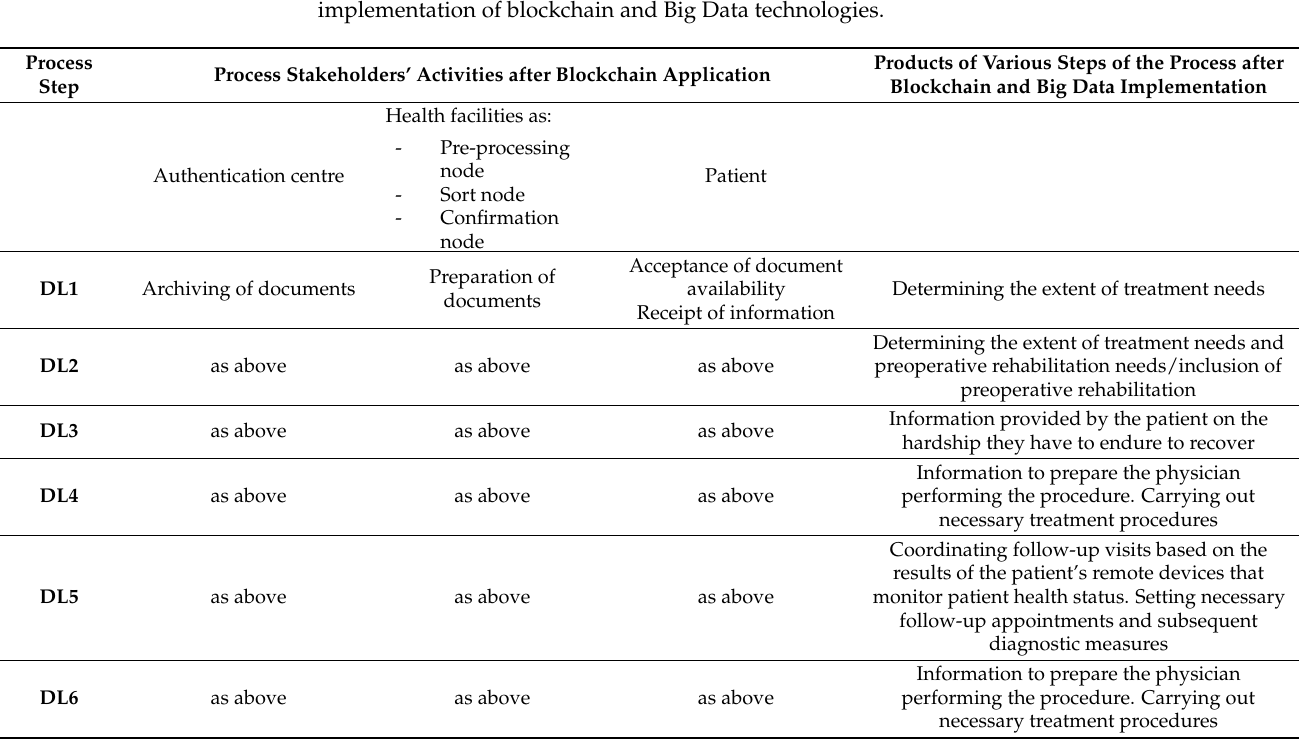
Table 3. Form for the simulation evaluation of the process. The assessment was made after possible implementation of blockchain and Big Data